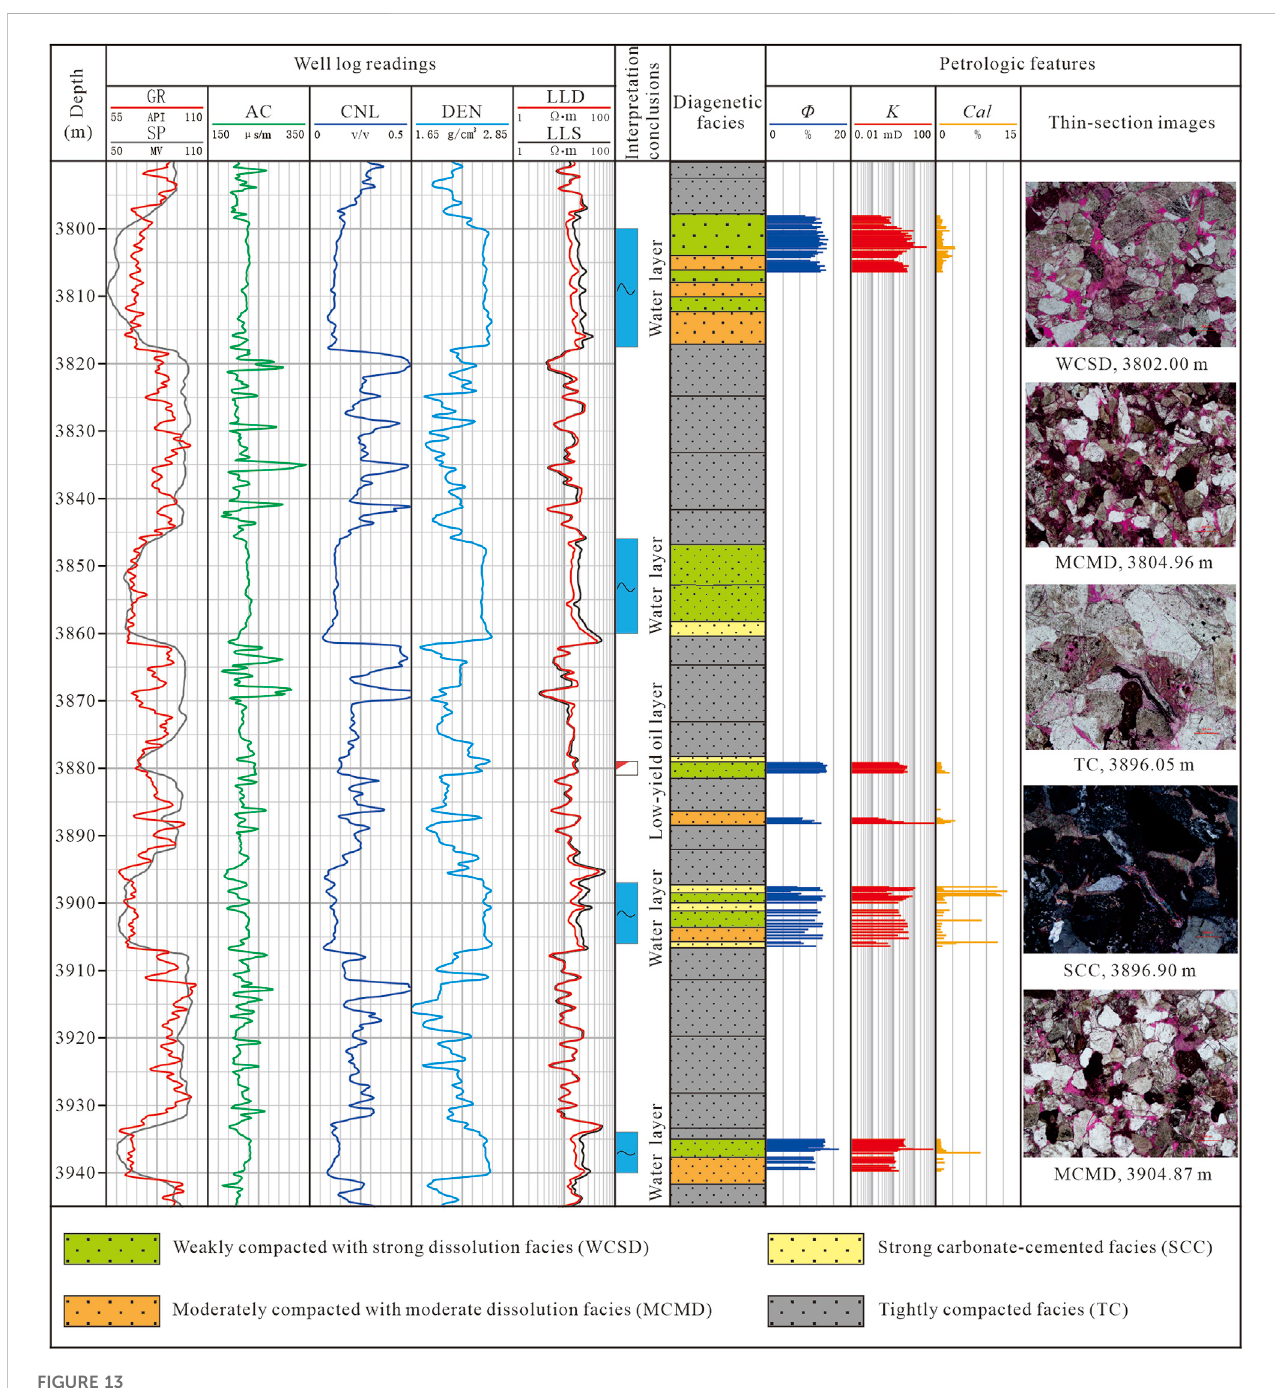
FIGURE 13 Prediction of diagenetic facies in the vertical pro fi le of well PB103. Φ -core porosity; K -core permeability; Cal -carbonate